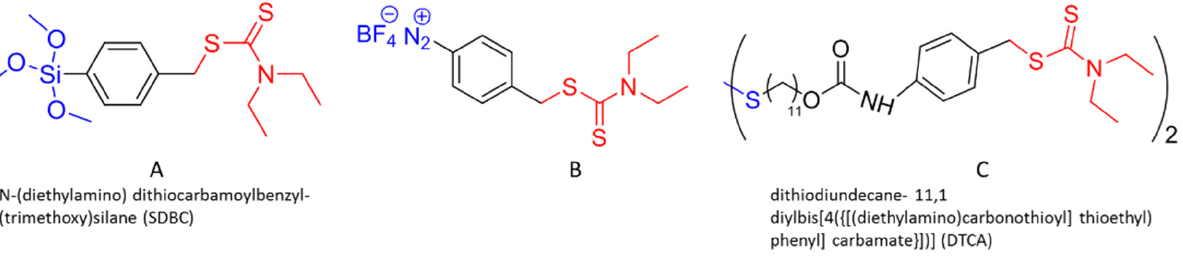
Figure 10. Iniferter compounds (red) bearing different anchor moieties (blue).